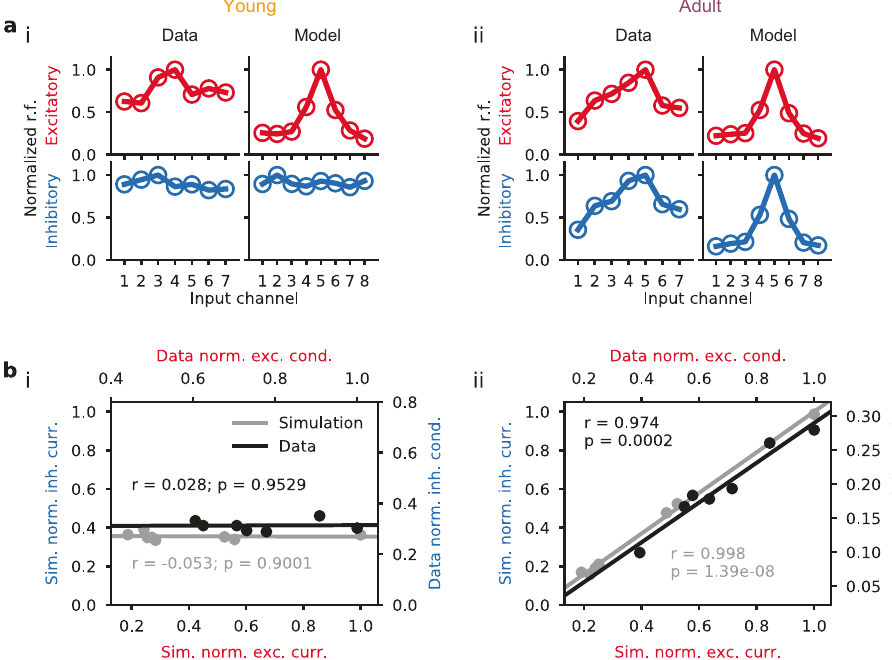
Fig. 3 Depression-to-facilitation shift captured inhibitory receptive fi eld development. a Comparison of experimentally observed and simulated (dev- STP model) excitatory and inhibitory tuning curves, for both young (i) and adult (ii) conditions. b Excitatory-inhibitory responses for model (gray) and experiments (black). Different dots represent different tone frequencies in the data and different input channels in the model. Lines represent linear correlation between excitatory and inhibitory responses in both model (gray) and experiments (black). Experimental data reproduced from a previous study 26